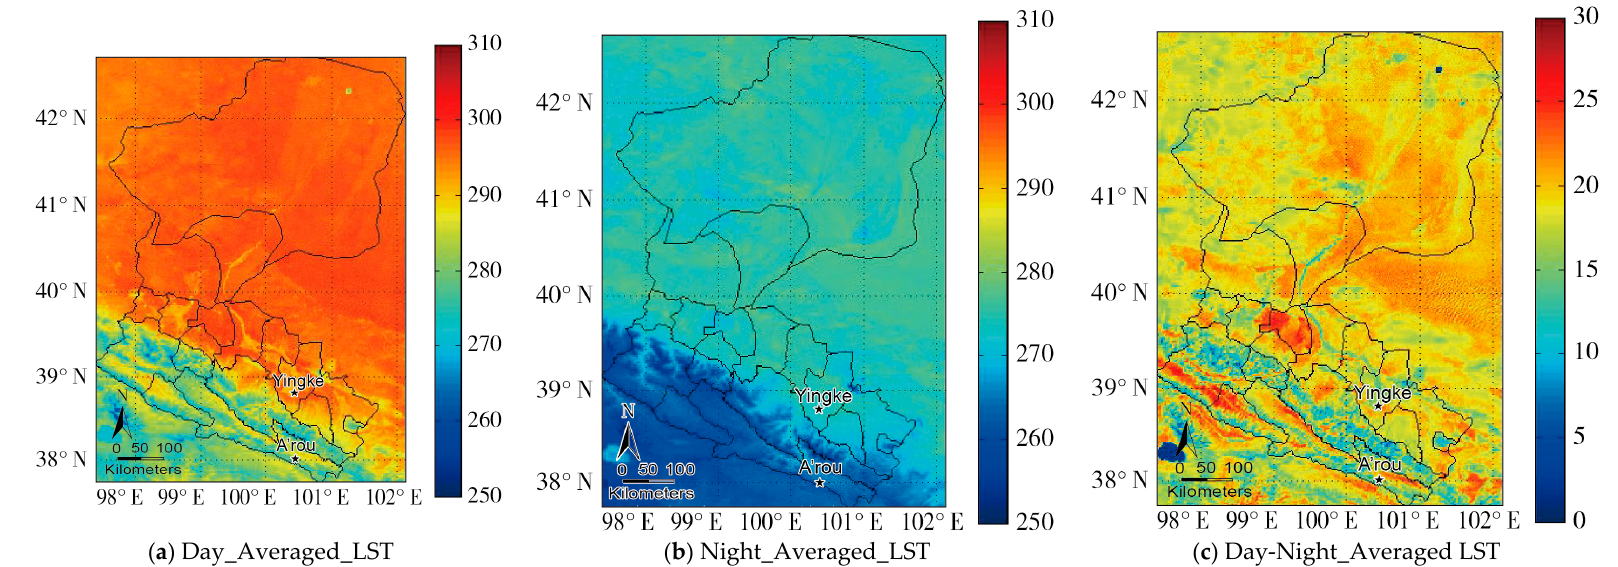
Figure 6. Nine-year (2003–2011) averaged AATSR LST: ( a ) daytime averaged LST; ( b ) nighttime averaged LST; and ( c ) the averaged difference between daytime and nighttime LST.